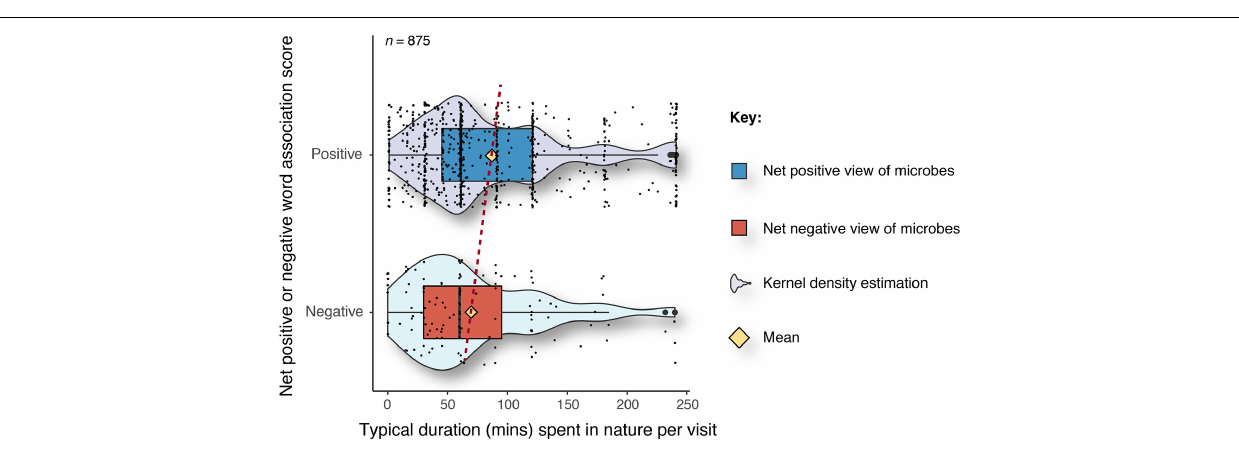
FIGURE 2 | Typical duration spent in natural environments per visit for respondents with net positive and net negative word-association scores. The yellow diamond represents the mean value. The dashed red line is a visual aid to track the difference in